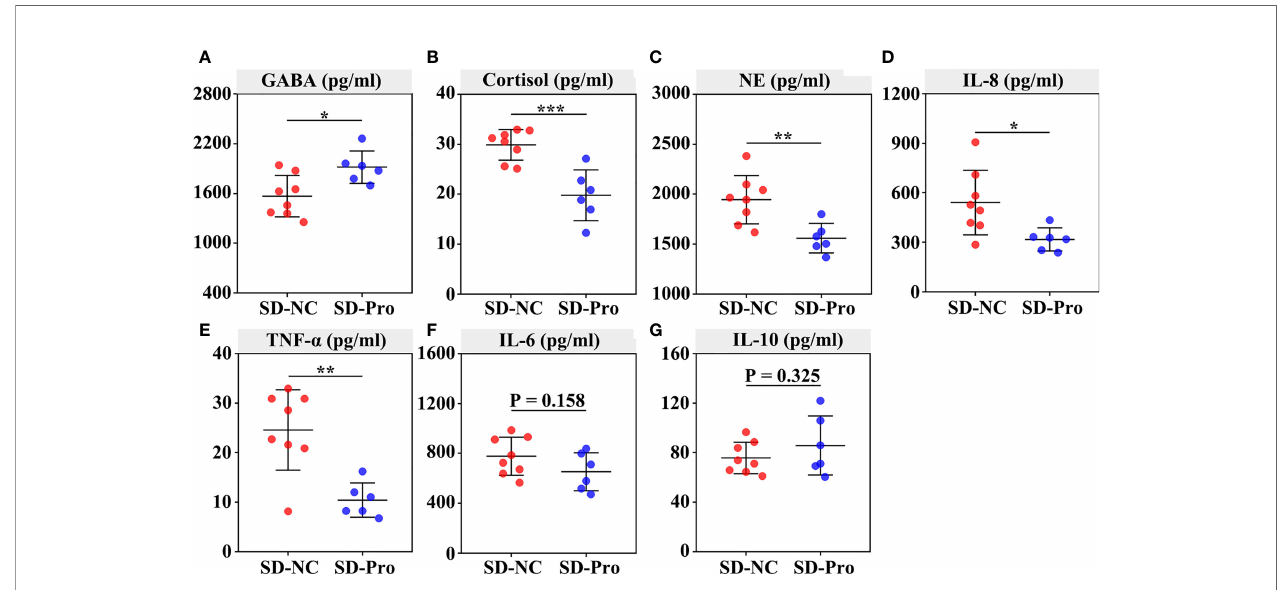
FIGURE 7 | Effects of probiotics on the secretion of plasma GABA, stress hormones, and cytokines in rhesus monkeys. The plasma was extracted from the centrifuged blood samples after 30 days of probiotics supplementation. The concentration of serum GABA (A) , cortisol (B) , norepinephrine (C) , IL ‐ 8 (D) , TNF ‐ a (E) , IL-6 (F) and IL ‐ 10 (G) were detected using ELISA assays. Differences were denoted as follows: *P < 0.05; **P < 0.01; ***P < 0.001. Abbreviations: SD-NC, SD control group; SD-Pro, SD group with probiotics